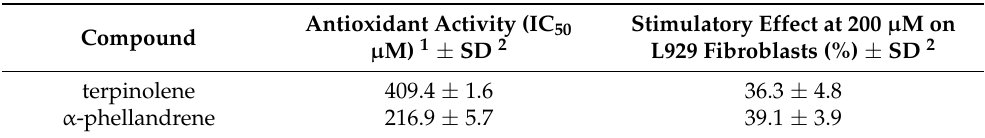
Table 2. Comparison of the antioxidant activities and maximum stimulatory effects on L929 fibroblast migration and proliferation of terpinolene and α -phellandrene